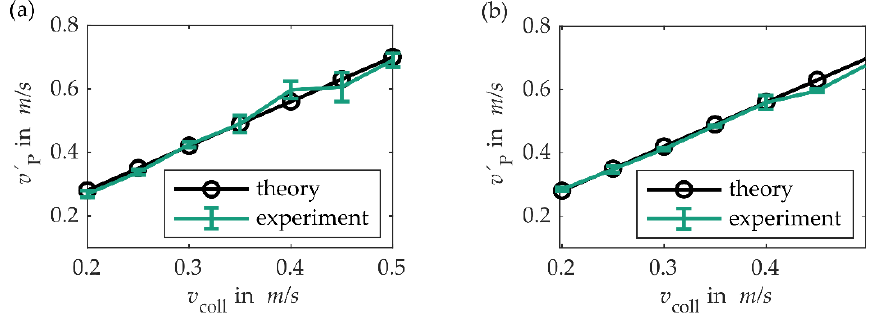
Figure 8. ( a ) Impact at 10 ms sampling rate; ( b ) impact at 5 ms sampling rate.